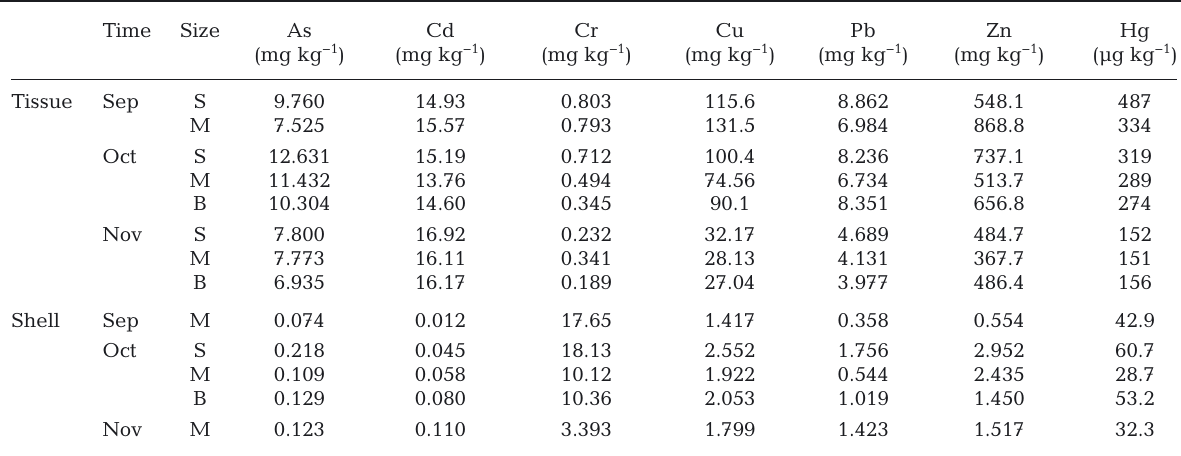
Table 3. Trace element (As, Cd, Cr, Cu, Zn, Pb and Hg) concentrations in tissue and shells of small (S), medium (M) and big (B) sized bay